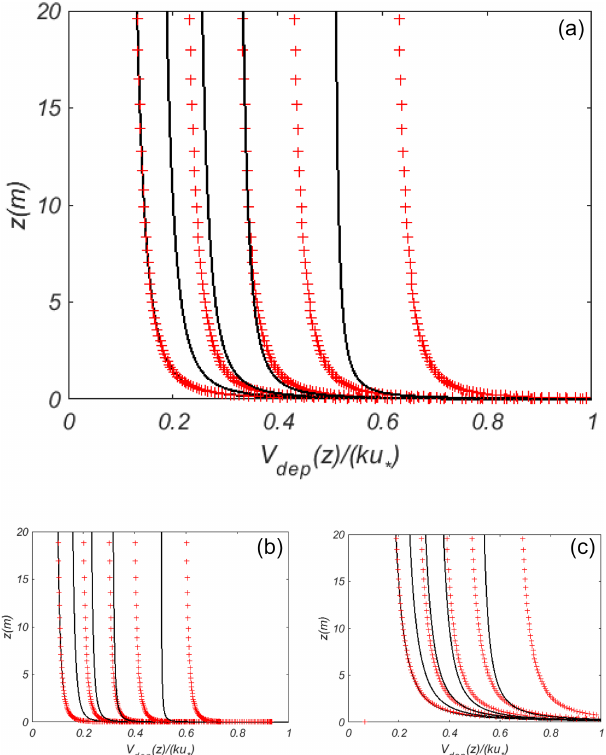
Figure 2. V dep profiles, from the surface to z = 20m in con- stant flux layers with gravitational settling. Solid lines are with the CFLGS model, the + points are from the Zhang–Slinn for- mulation (ZS). The five cases, left to right, are S = 0, S = 0 . 1, S = 0 . 2, S = 0 . 3 and S = 0 . 5. (a) z 0m = z 0c = 0.01m; R s = 0. (b) z 0c = 0.001m; z 0m = 0.01m; ku ∗ R s = 2.3. (c) z 0c = 0.1m; z 0m = 0.01m; ku ∗ R s = − 2.3.